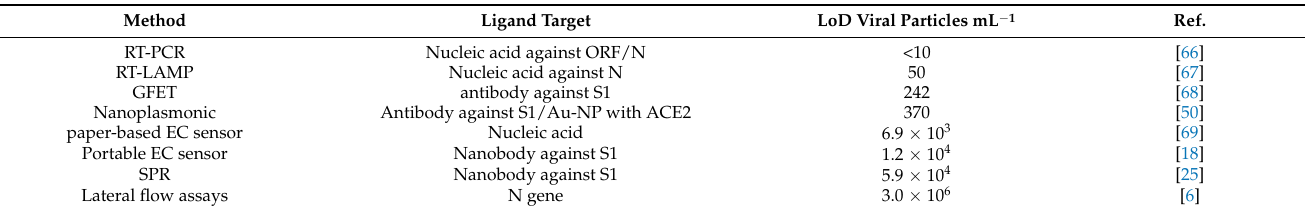
Table 1. Comparison of different SARS-CoV-2 detection